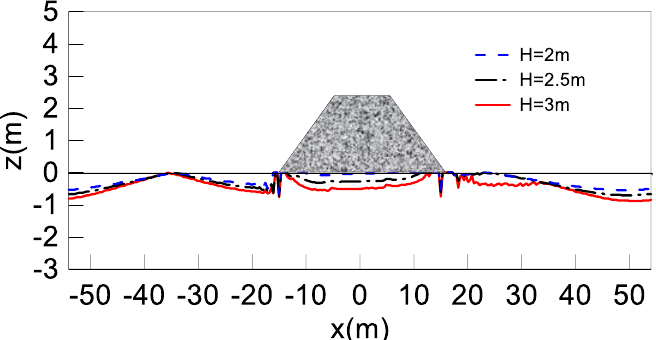
Figure 11. Development of the liquefaction depth around the breakwater with various wave heights. Note that the wave parameters used in the above example are not near breaking wave conditions. This is to reduce the computational domain and time. For the extreme wave conditions, the present model can be applied but requires significant computation cost. Since the objective of this paper is the development of mesh-free method and its application, we only used non-breaking wave conditions as